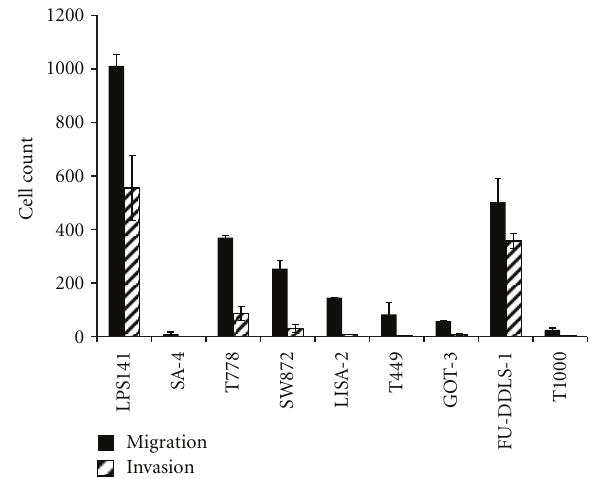
Figure 5: In vitro migration and invasion potential of the LPS cell lines . Cells were incubated for 22